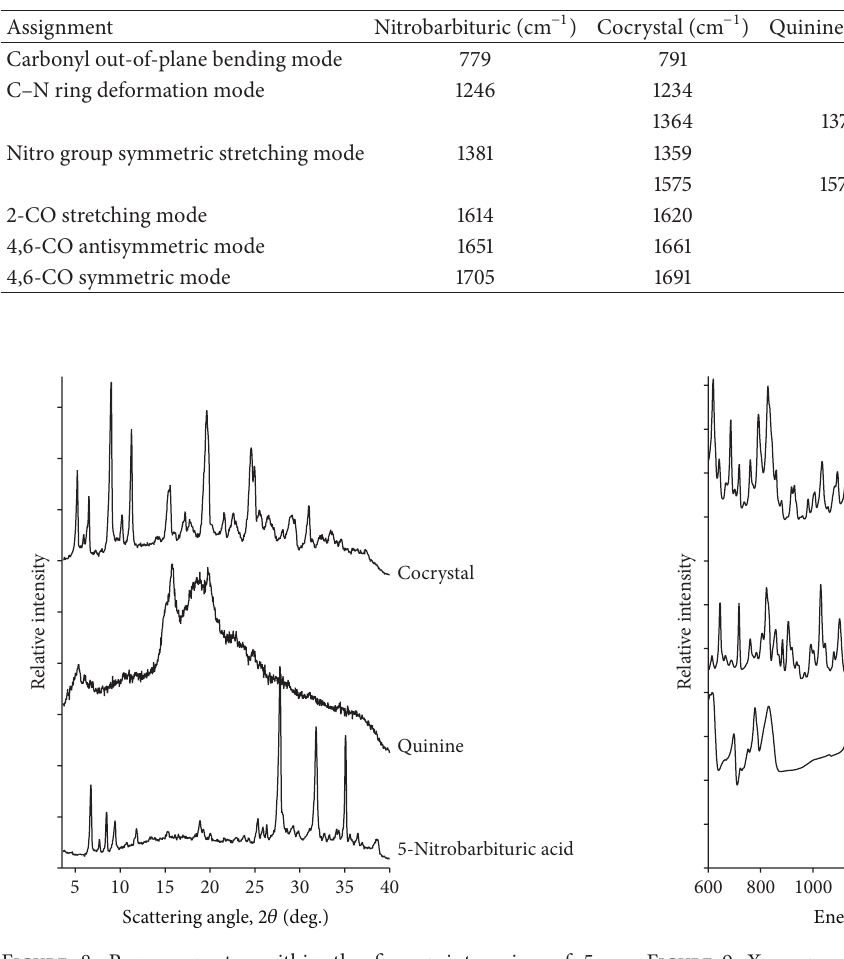
Figure 9: X-ray powder diffraction patterns of 5-nitrobarbituric acid, quinine, and the 1: 1 nitrobarbituric-quinine